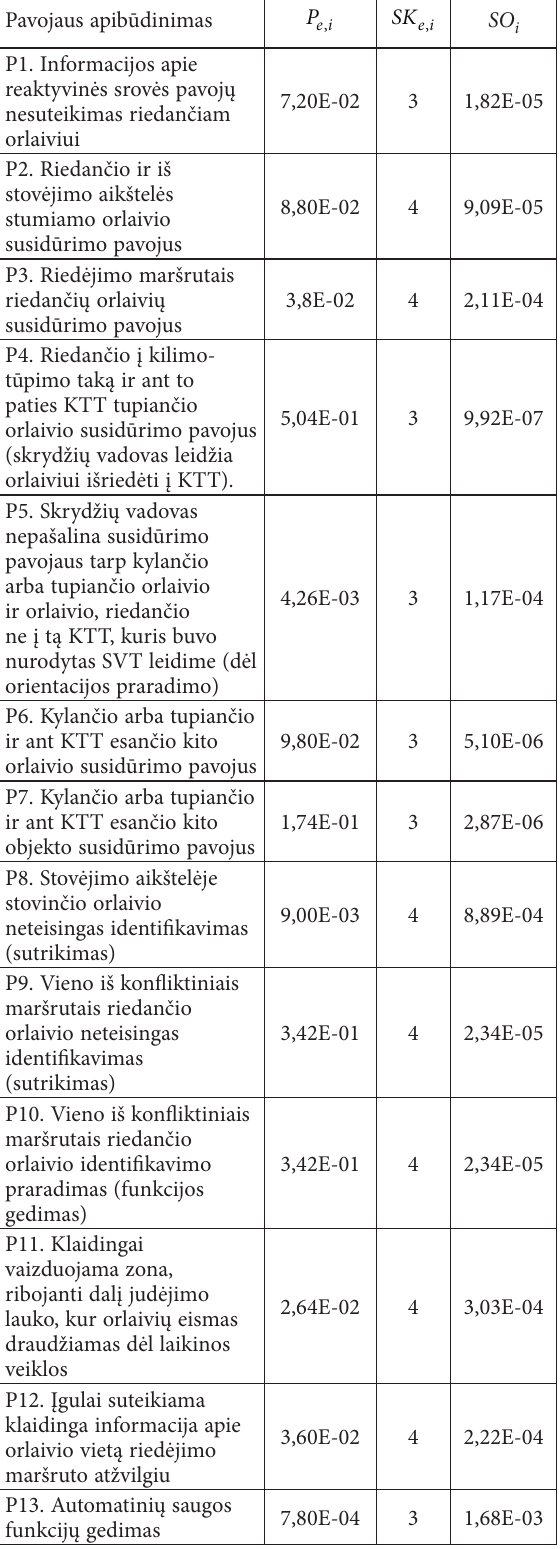
Table 3. A-SMGCS safety objectives’ summary Pavojaus